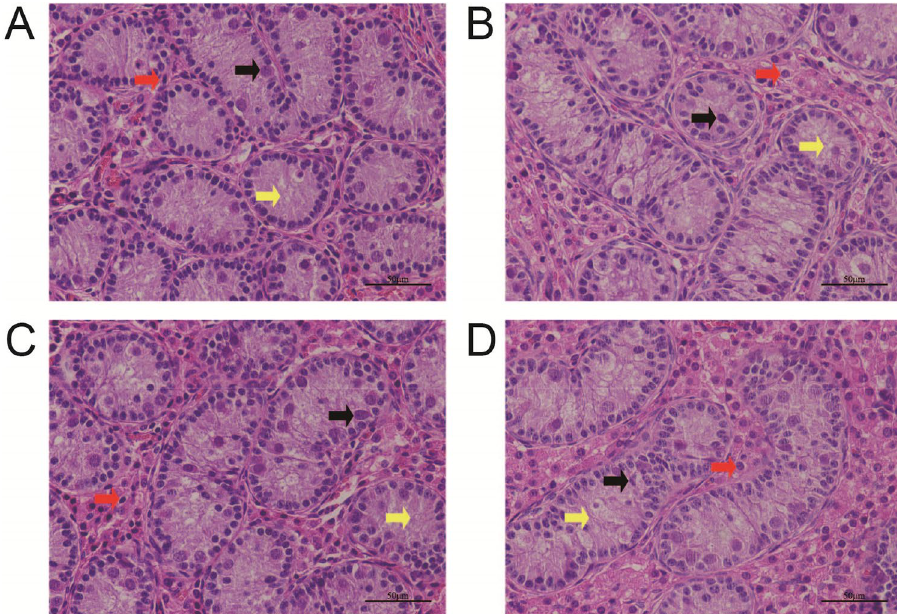
Figure 2. Paraffin section of testes at 82 days of age (HE staining). Black arrows indicate Sertoli cells (SC), red arrows Leydig cells (LC) and yellow arrows seminiferous tubules (ST). scale is 50 μm. ( A ) control diet; ( B ) control diet supplemented with 1 μg/kg 1α,25(OH) 2 VD 3 ; ( C ) control diet supplemented with 2 μg/kg